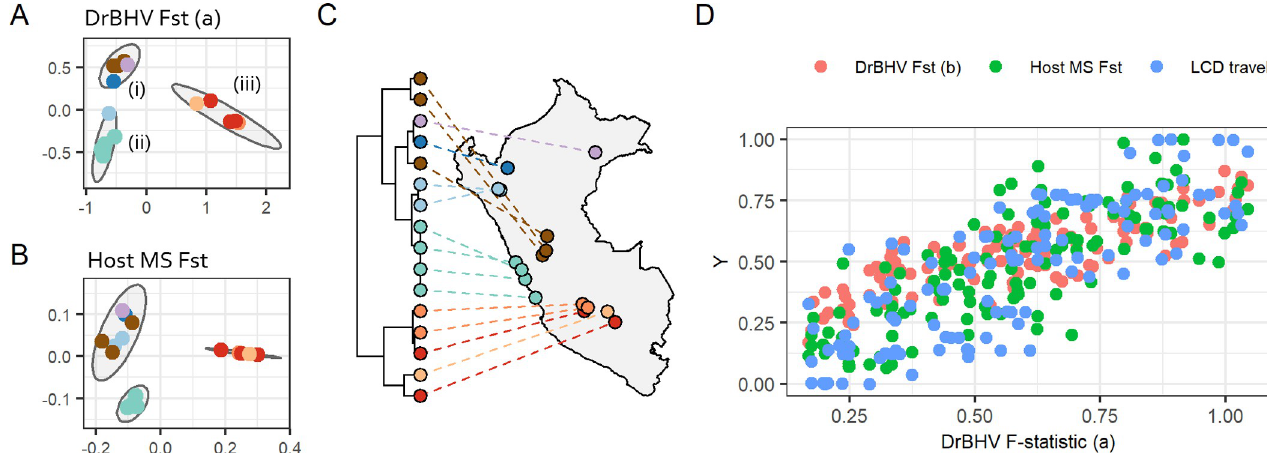
Fig 3. Parallel population structure of DrBHV and vampire bat hosts. Multidimensional scaling plots of the pairwise F ST between geographic groups of (A) DrBHV based on SNP read depth from UL54-56 and (B) D . rotundus MS data. Panel (C) shows a dendrogram representing LCDs between sampled colonies based upon elevation, with tips coloured by department of Peru (base map: https://www.evl.uic.edu/pape/data/WDB). Panel (A) shows 3 distinct clusters comprising (1) Loreto—purple, Amazonas—dark blue, and Hua´nuco—brown; (2) Lima—green and Cajamarca—blue; and (3) the southern region (Ayacucho, Cusco, and Apurı´mac). Panel (B) shows similar clustering with the exception that Cajamarca now clusters more closely with (1) than with (2). Panel (D) shows strong correlations between pairwise DrBHV Fst (a—based on the full complement of SNPs) and 3 other distances matrices: DrBHV Fst (b—SNPs from UL55 not included) (red), host microsatellite Fst (blue), and pairwise distances based on the least-cost landscape model (green). Data underlying this figure can be found in S3 Data. DrBHV, Desmodus rotundus betaherpesvirus; LCD, least-cost distance; MS, microsatellite; SNP, single nucleotide polymorphism.